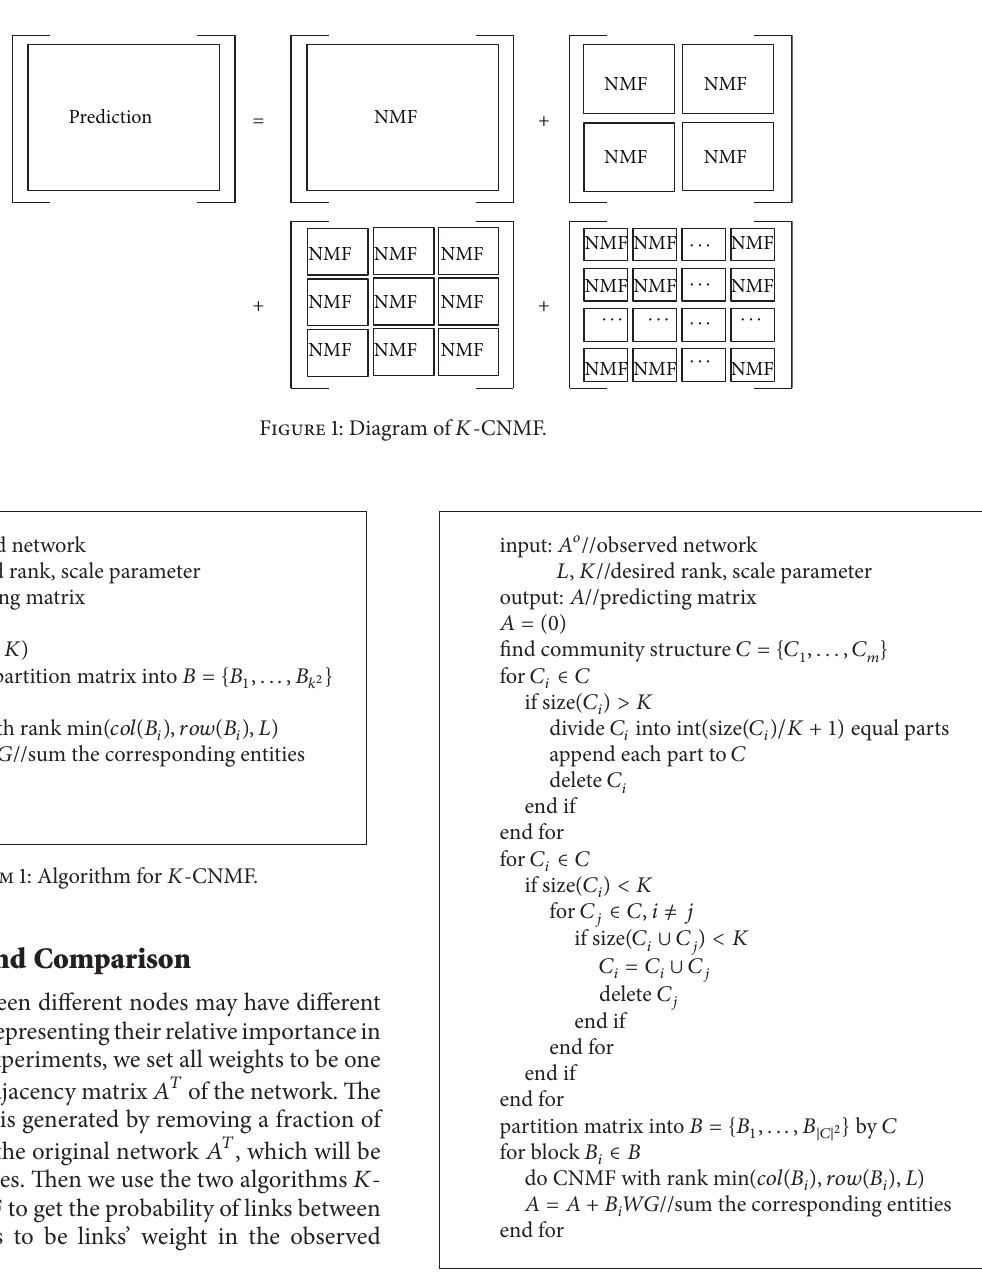
Algorithm 2: Algorithm for 𝑀